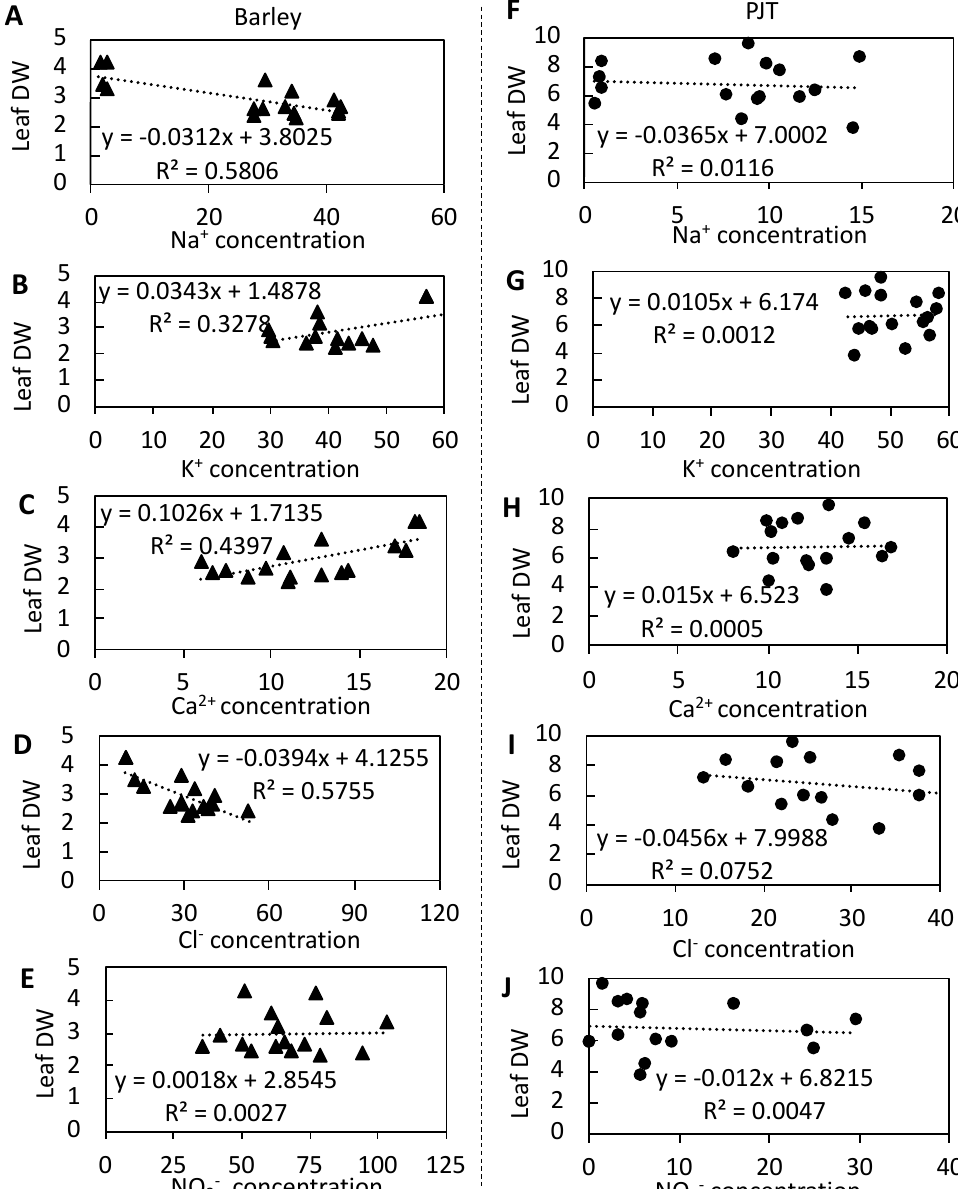
Figure 4. Correlations between ion concentrations (Na + , K + , Ca 2+ , Cl − , and NO 3− ) in barley ( ) leaves (from A to E ) and dry leaf weights and in Peucedanum japonicum (•) leaves (from F to J ) and dry leaf weights at different NaCl concentrations.